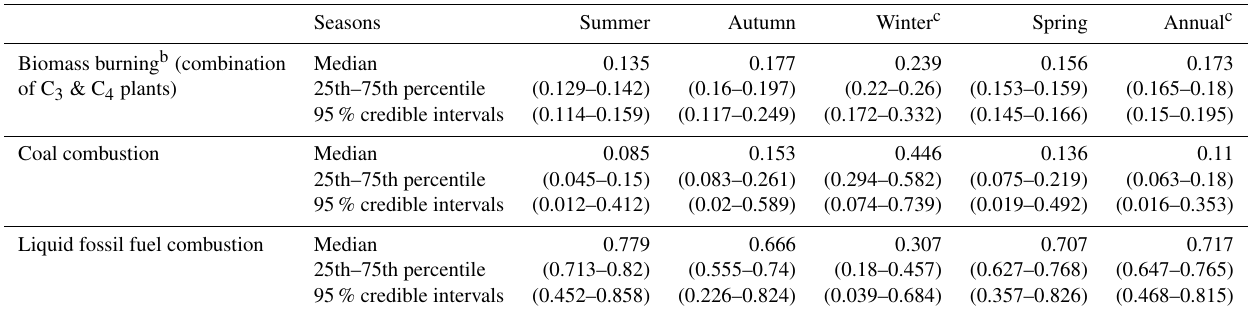
Table 2. MCMC4 results a from the F 14 C- and δ 13 C-based Bayesian source apportionment calculations of EC (median, interquartile range (25th–75th percentile), and 95% credible